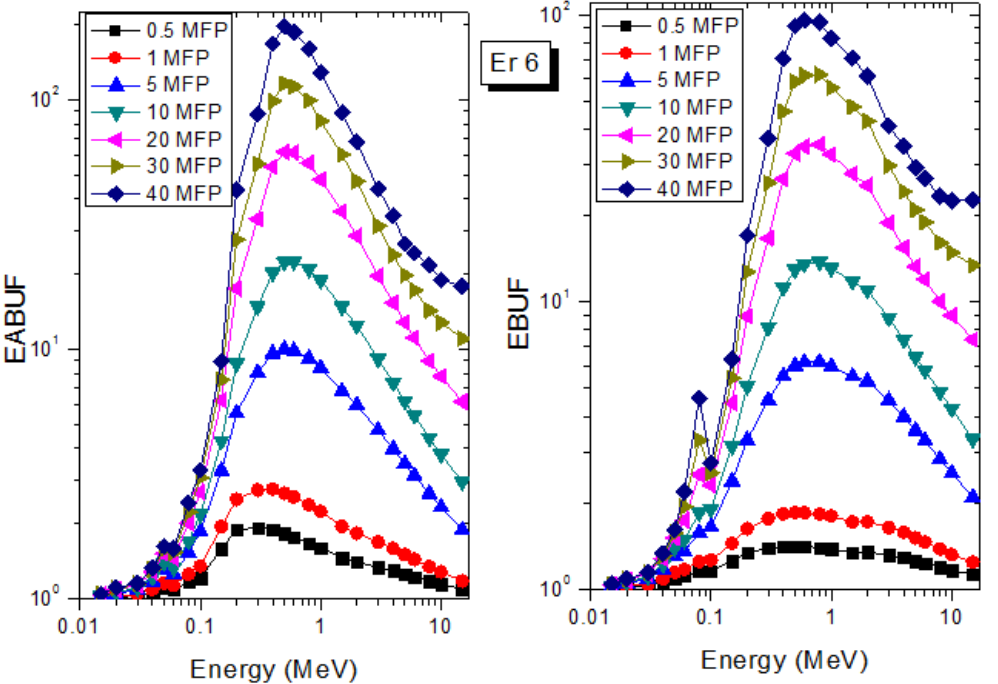
Figure 6. EABUF and EBUF variation with gamma-ray photon energy for Er 6.